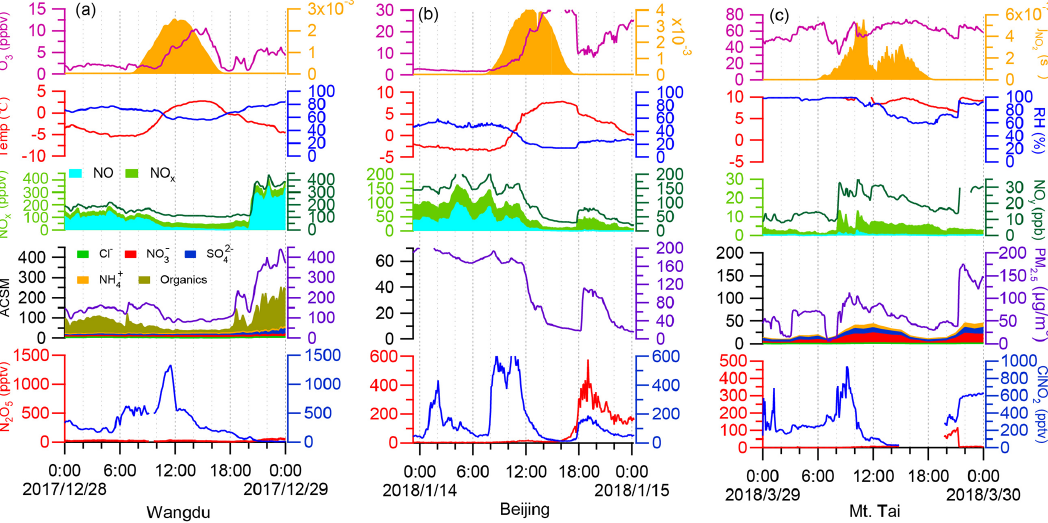
Figure 7. Examples of daytime peaks of ClNO 2 levels observed at (a) Wangdu, (b) Beijing, and (c) Mt. Tai in the winter campaigns. These examples show the highest levels of daytime ClNO 2 at each site. The ionic composition of aerosols was not available on 14 January 2018, owing to an instrument problem.